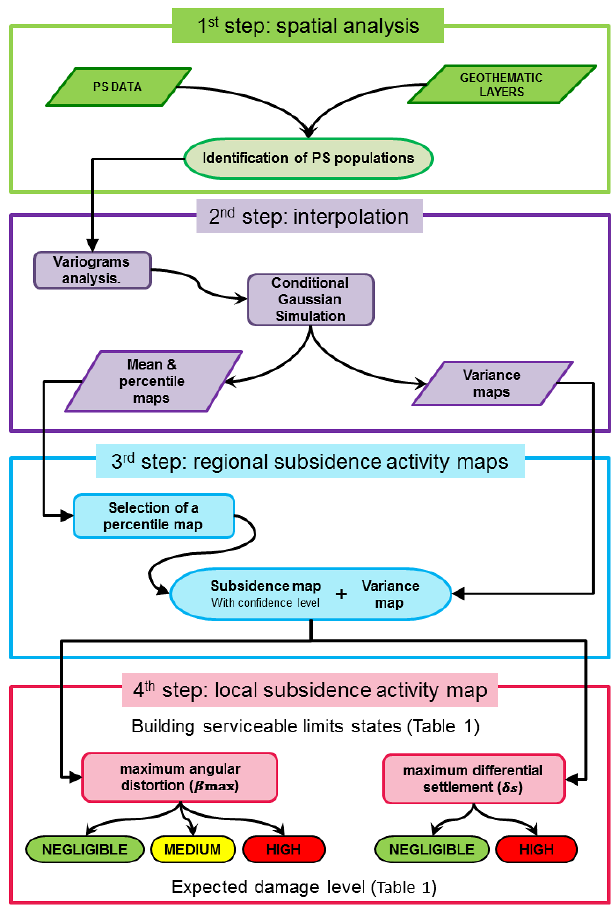
Figure 2. Proposed methodology for the elaboration of subsidence activity